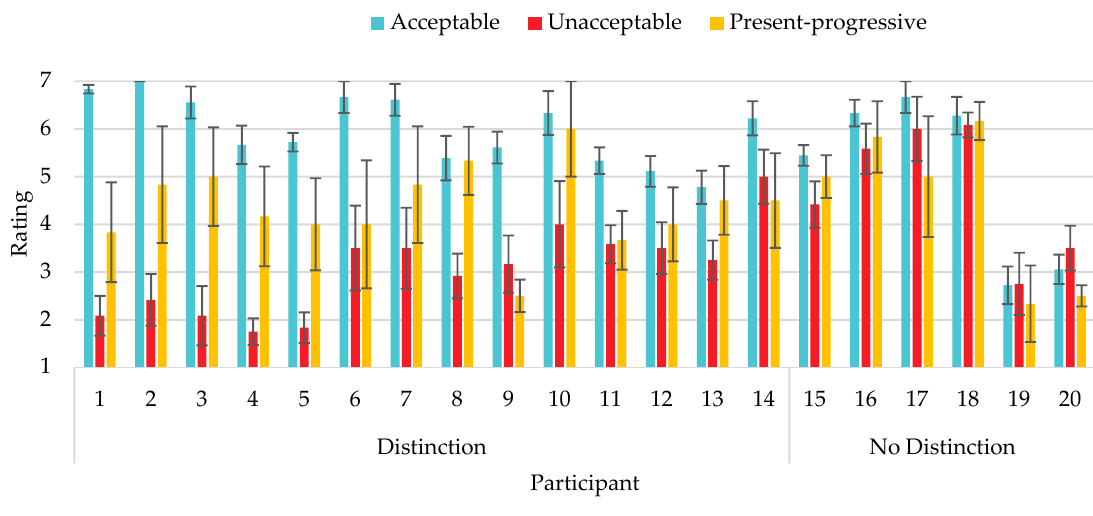
Figure 4. Mean rating of all stimuli by participant group and switch type.